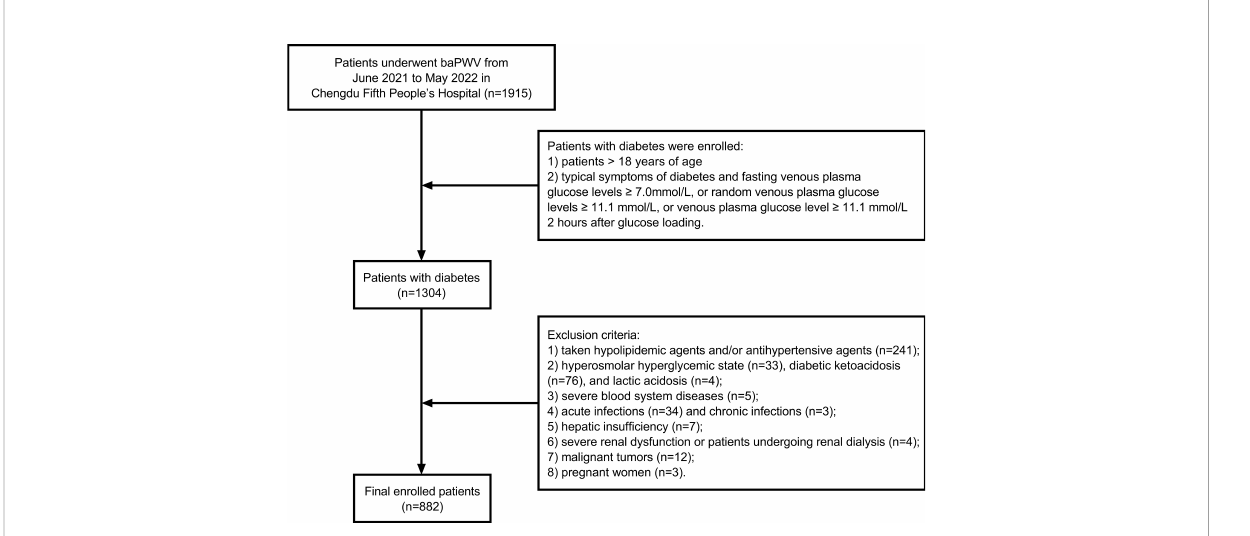
FIGURE 1 Flow chart of the study population